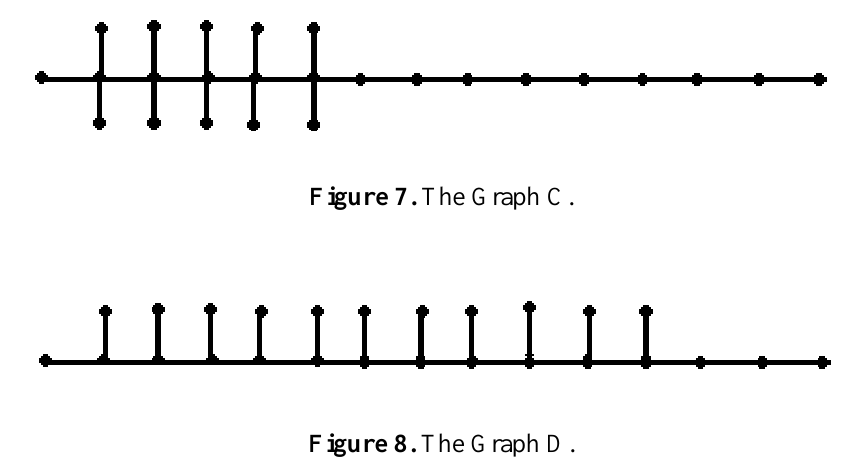
Figure 8. The Graph